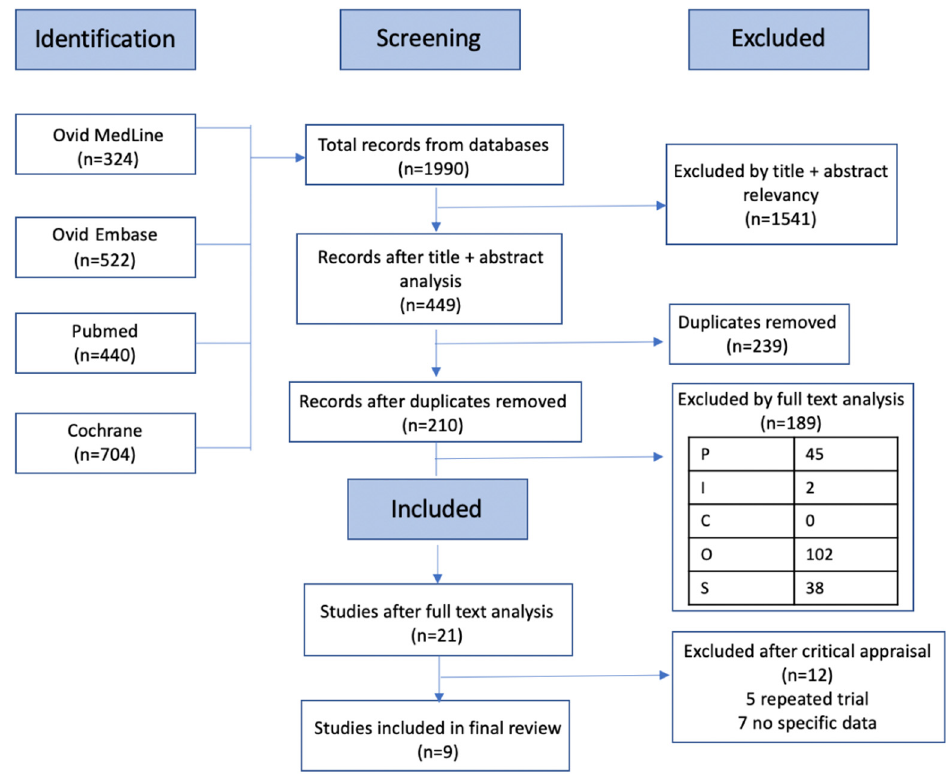
Figure 1. Flow diagram displaying literature search protocol. Adapted from PRISMA 2009 flow diagram [10].